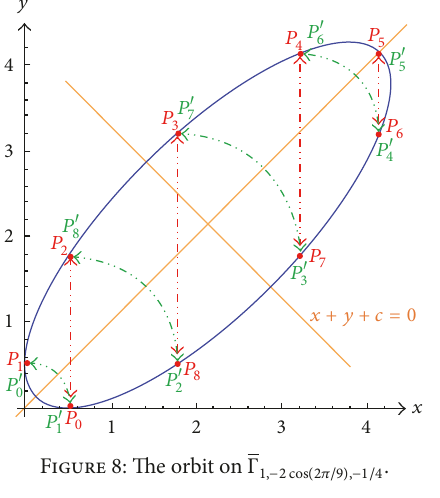
Figure 10: The orbit on Γ 0,2,4 .